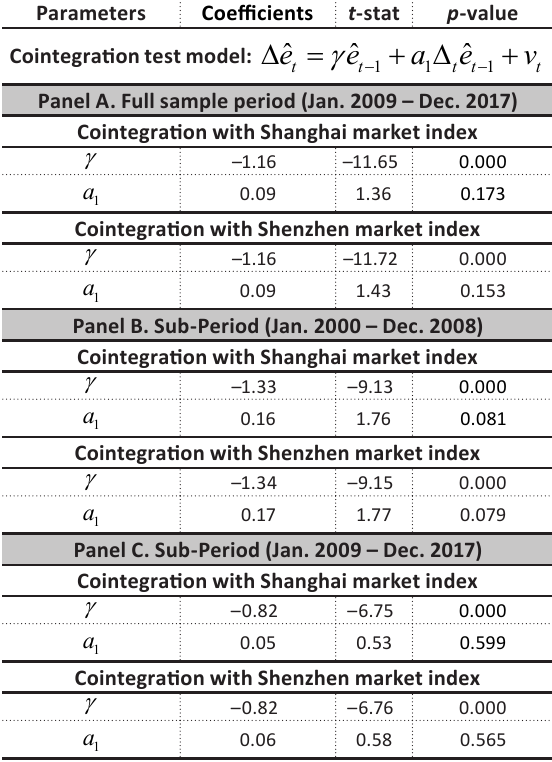
Table 6. Engle-Granger cointegration tests (Jan.